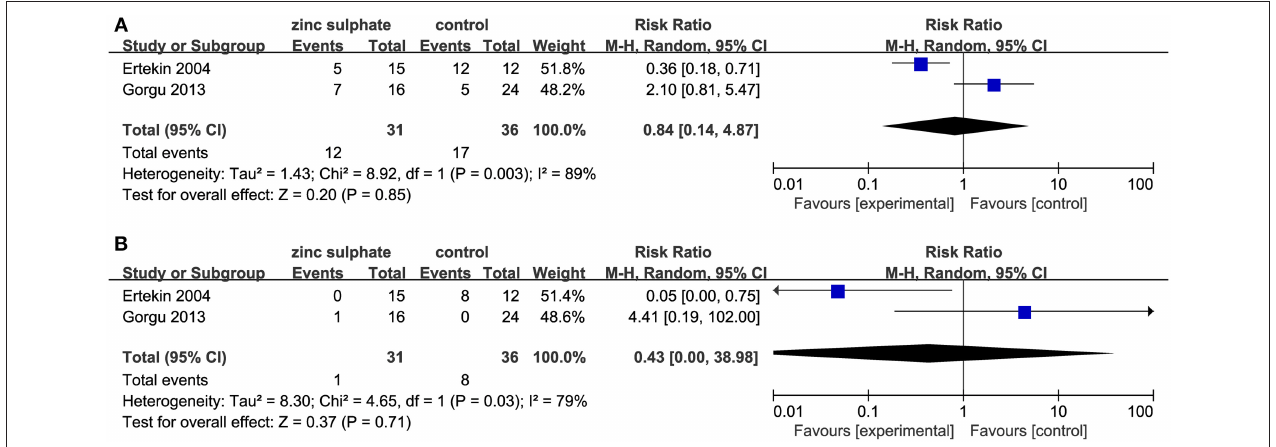
FIGURE 4 | Meta-analysis of severity of oral mucositis: (A) Moderate and severe oral mucositis and (B) severe oral mucositis